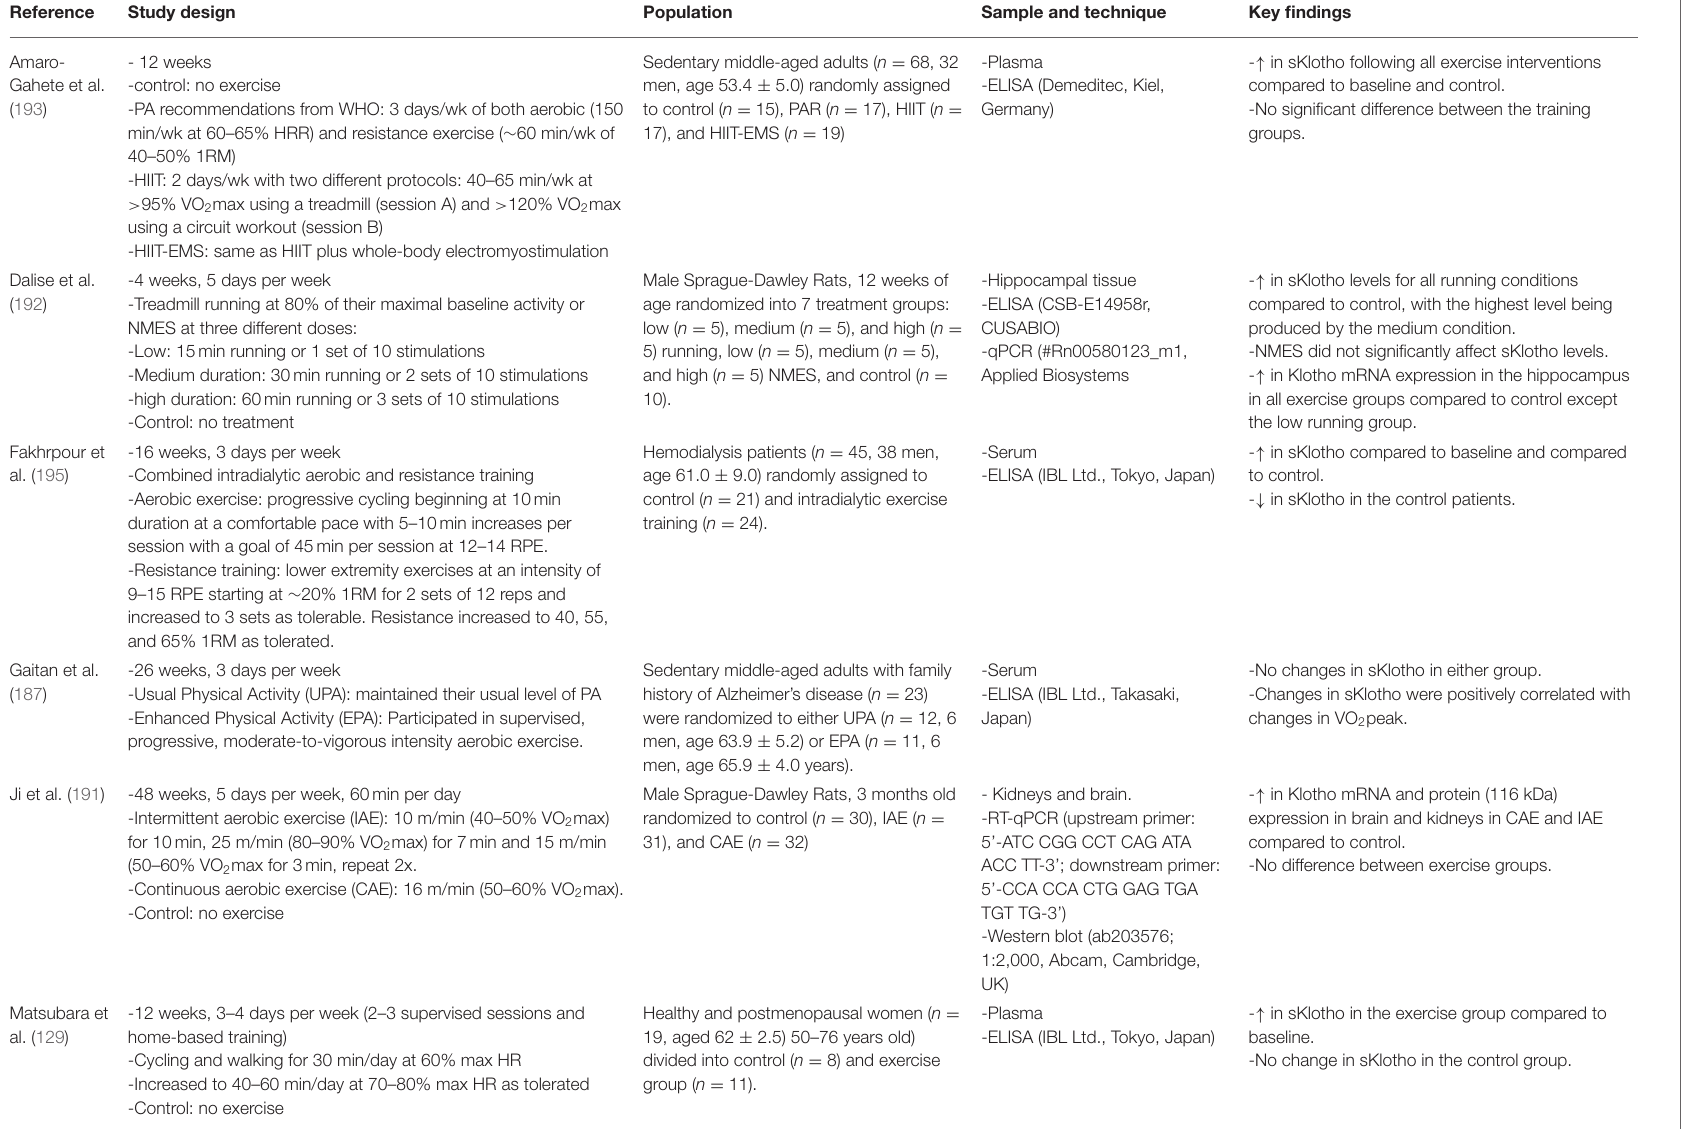
TABLE 3 | Effects of exercise training on Klotho